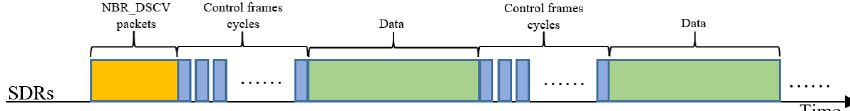
Figure 1. Time division multiple access (TDMA) frame cycles in proposed virtual sub-nets based cross-layer medium access control (VSCL-MAC) design.